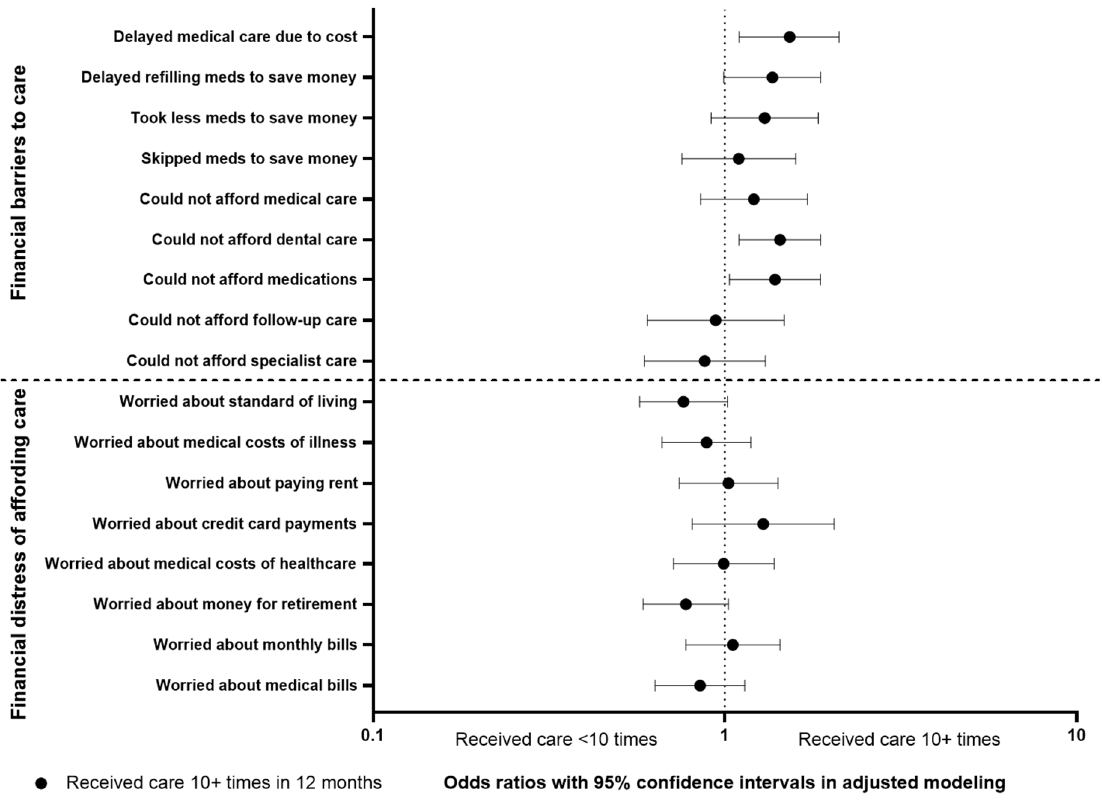
Figure 2. Multivariable analyses of association between medical care utilization (represented by receiving care 10+ times in 12 months) and study outcomes in the domains of financial barriers to care and financial distress of affording care.